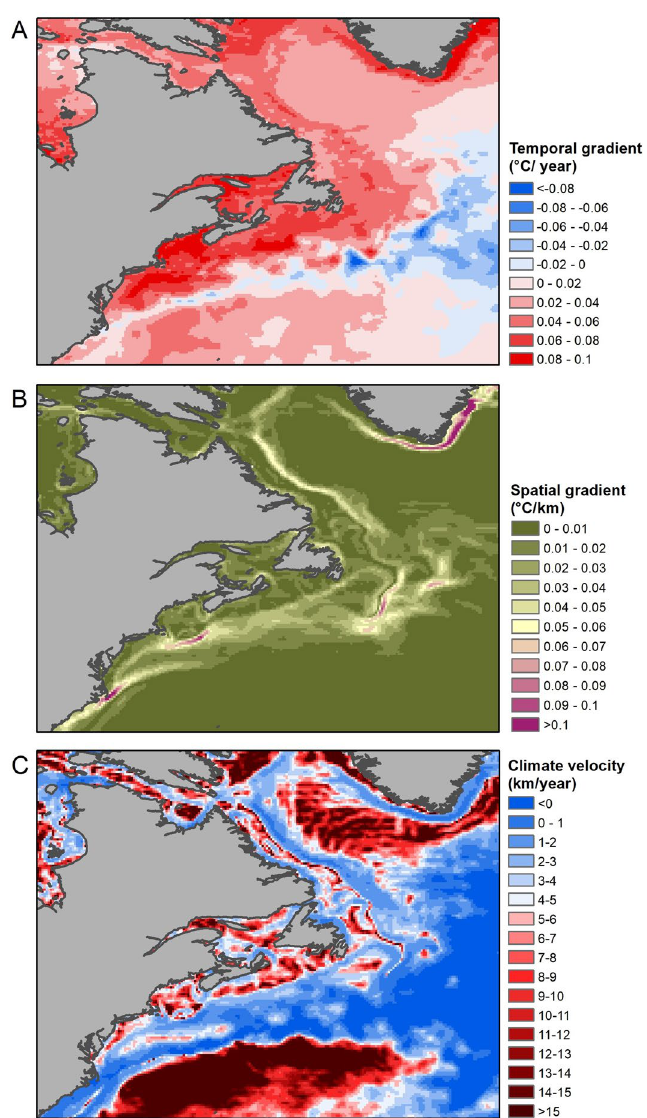
Figure 2. Temporal ( A ) and spatial ( B ) gradients in fall sea surface temperature used to calculate the velocity of climate change ( C ) in the Northwest Atlantic, calculated from 1992–2016. Climate velocity represents the rate at which isotherms move. Higher values of climate velocity represent faster poleward movement of isotherms. Maps produced using ArcGIS (v. 10.8.1).